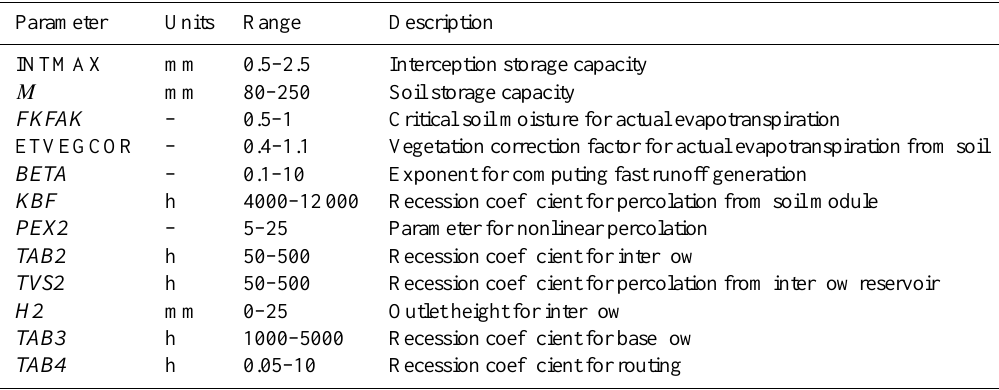
Table 2. Model parameters θ i . Parameters in italics are calibrated.